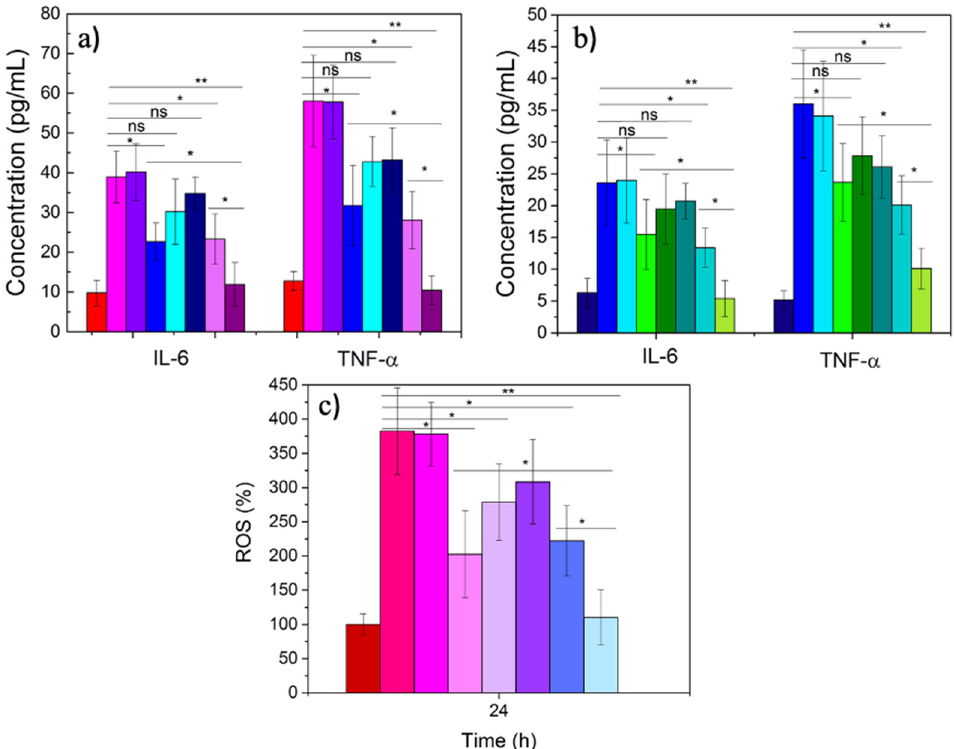
Figure 3. Production of cytokines in the absence and presence of the platform in ( a ) RAW 264.7 macrophages and ( b ) HUVEC cells; ( c ) ROS production in the absence and presence of the platform in RAW 264.7 macrophages. From left to right column: control cells, activated cells (100 ng/mL LPS), free miRNA (100 nM), free ATOR (20 mM), ATOR-PLGA NPs (5 × 10 10 NPs/mL, 20 mM drug), PLGA/miRNA NPs (5 × 10 10 NPs/mL, 100 nM miRNA), and ATOR-PLGA/miRNA NPs at 1.0 × 10 10 (4 mM drug-20 nM miRNA) and 5.0 × 10 10 NPs/mL (20 mM drug-100 nM miRNA). Statistical significance compared to LPS-activated cells: * = p <0.05; ** = p < 0.01; ns = non statitiscallr significant.